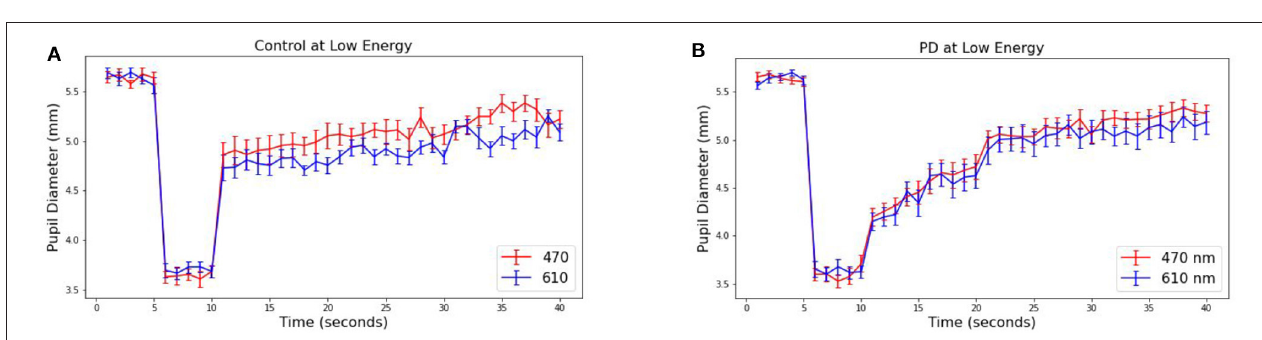
FIGURE 4 | Average pupillary response ( ± SEM) to blue (470) and red (610) light for (A) Control and (B) PD subjects at 8 µ